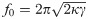
GCMC simulation of a triangulated membrane patch.(a) Sketch of the simulation setup. The area of a small fluctuating membrane patch is coupled grand canonically to an implicit lipid reservoir at constant surface tension, mimicking the large excess of vesicle area in typical experiments. (b) The control parameter fugacity z can be mapped to surface tension γ in simulation (black crosses) and fitted using Eq (2) (red line). Simulation snapshots are shown for fugacities, z = 13 and z = 29. Inset sketch: GCMC node removal and insertion moves. (c) Membrane force-extension curves (black) compared to zero-temperature calculations at κ = 20kBT and γ = {0.005;0.01;0.02}kBTnm−2 (red solid lines from bottom to top, respectively). Asymptotic pulling force, f0=2π2κγ (red dashed lines). Simulation snapshots are shown at tube extensions L around 72nm, 188nm, and 540nm, with γ = 0.01kBTnm−2. (d) Effective polymerization rate kon(n)/kon,0 (black solid) of a single rigid filament comprising n monomers compared to the expected near-equilibrium behavior (red dashed), for κ = 20kBT and γ = {0.005;0.01}kBTnm−2 (upper and lower curves, respectively). Snapshots are shown for γ = 0.01kBTnm−2.